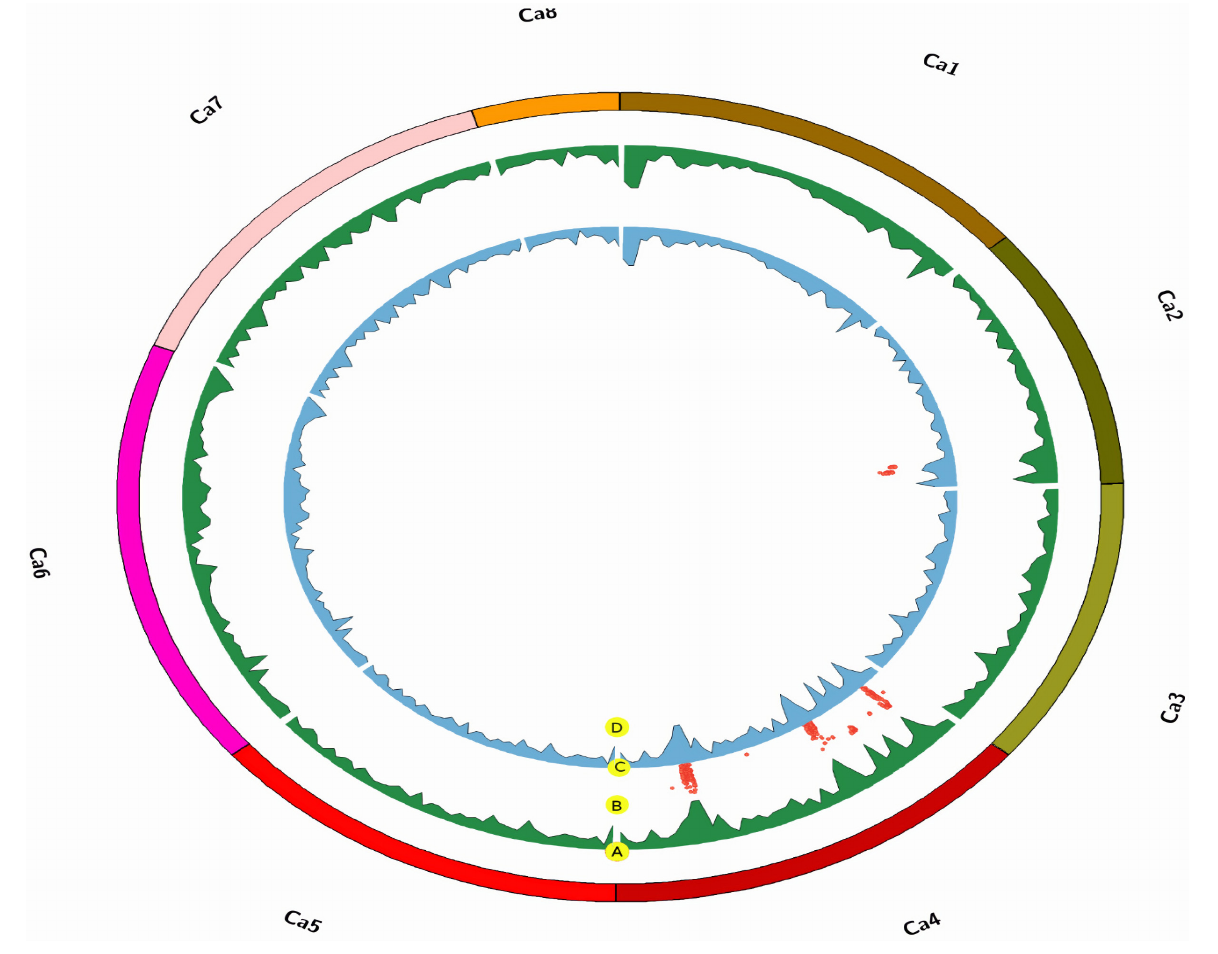
FIGURE 4 | Chromosomal distribution of SNP markers in the chickpea genome, where (A) is the density of the AB 482 population (per 1 Mbp), (B) is the marker LOD score (red points) between both populations, (C) is the density of the AB 3279 population (per 1 Mbp), (D) is the marker LOD score (red points) only for AB 3279